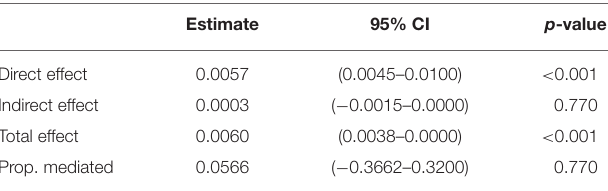
TABLE 5 | The mediation of the effect of Hcy on the poor outcome by